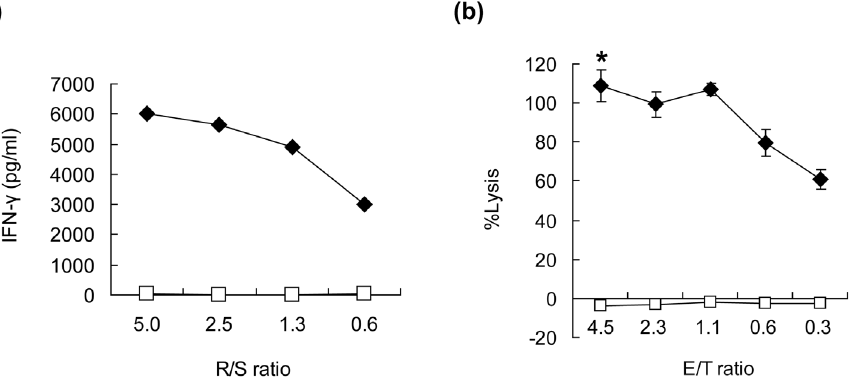
Figure 3. The IFN- c production and cytotoxic activity of a HIG2-9-4 peptide-specific CTL clone. (a) An established CTL clone was stimulated with T2 cells pulsed with the HIG2-9-4 peptide (closed diamonds) or HIV peptide (open squares). The IFN- c production in the culture supernatant was examined by ELISA. R/S ratio; responder/stimulator ratio. (b) The cytotoxic activity of the HIG2-9-4 peptide-specific CTL clone was examined against peptide-pulsed T2 cells (close diamond) or T2 cells pulsed with the HIV peptide (open square). E/T ratio; effector/target ratio. All experiments were performed in triplicate. The representative results from three independent experiments are shown. * P , 0.001